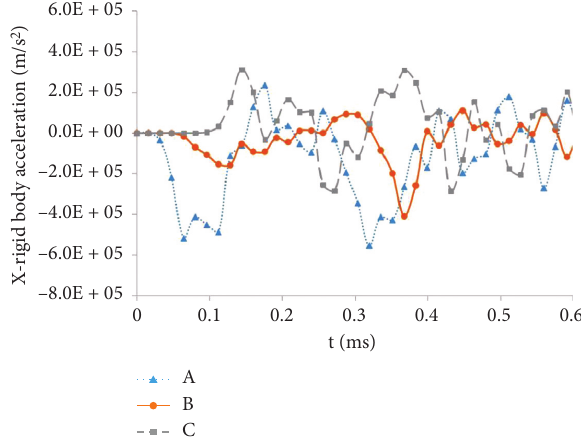
Figure 13: Acceleration curve in the X -direction at different po- sitions of the